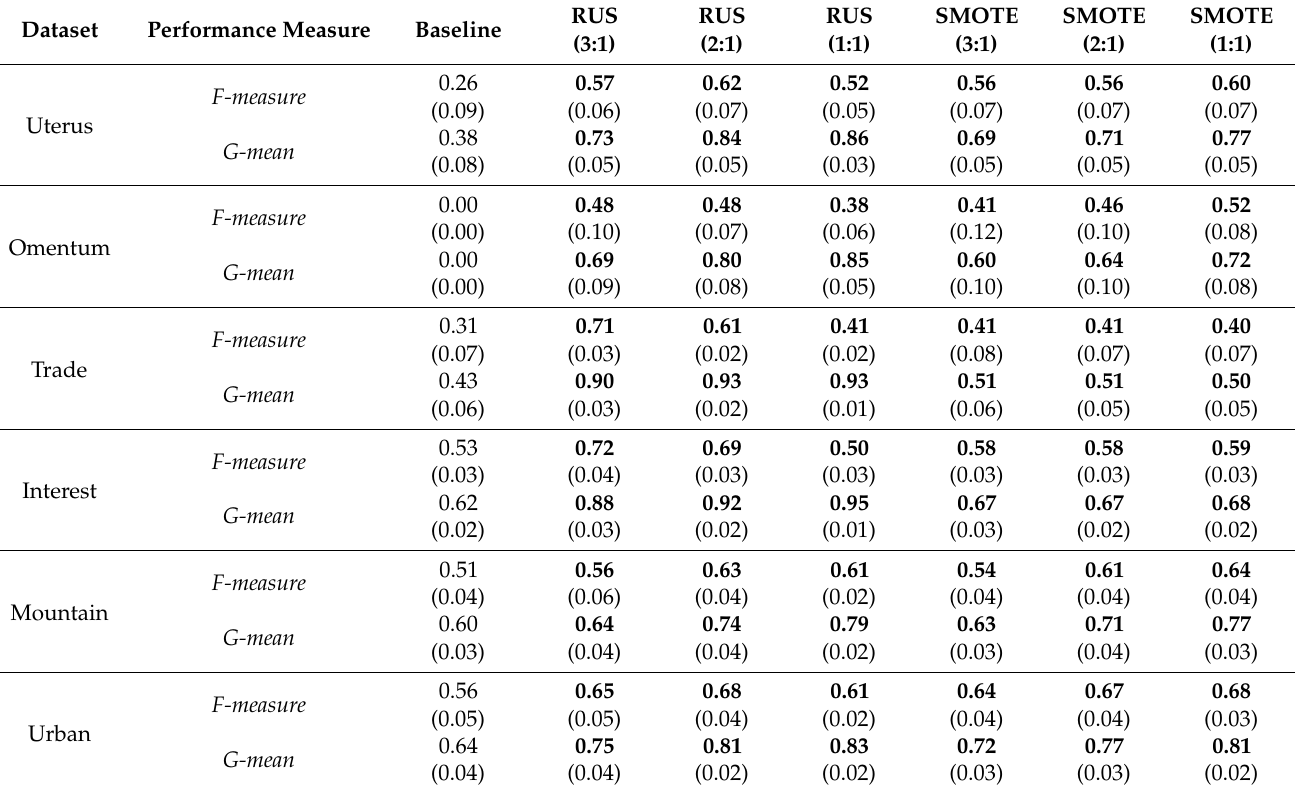
Table 3. F-measure and G-mean performance of the RF classifier, with and without data balancing.